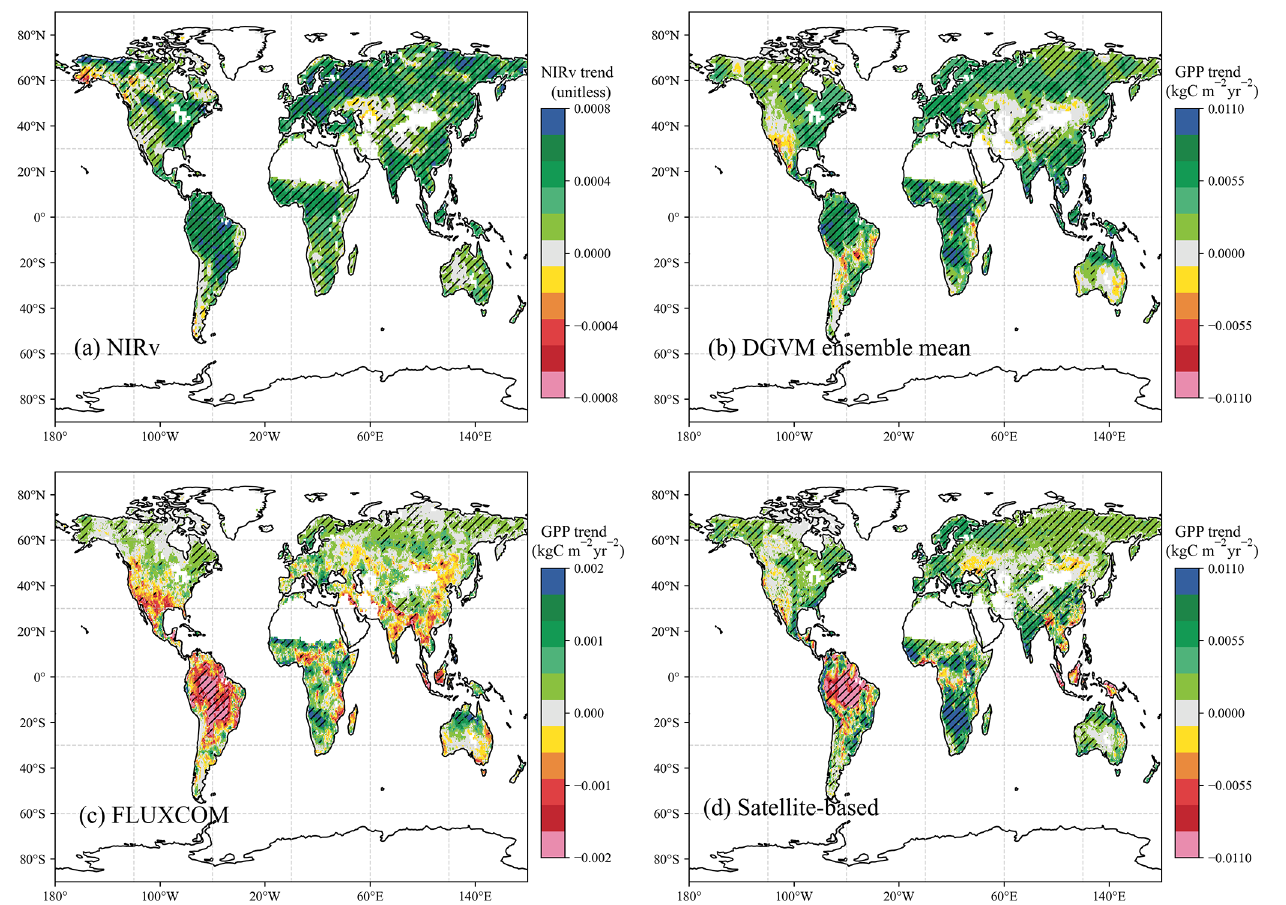
Figure 1. Geographical distributions of linear trends of NIRv and GPP during 1982–2015. (a) AVHRR NIRv, (b) ensemble mean of TRENDY multi-model-simulated GPP, (c) FLUXCOM GPP, (d) mean of satellite-based products from revised EC-LUE and GLASS GPP. Striped areas indicate that the trends are significant with p < 0 . 05 following the non-parametric Mann–Kendall trend test. The trends of NIRv and GPP are unitless and in kgCm − 2 yr − 2 , respectively. Additionally, due to a lack of the CO 2 fertilization effect in FLUXCOM GPP (c) , we used a smaller scale than in panels (b) and (d)